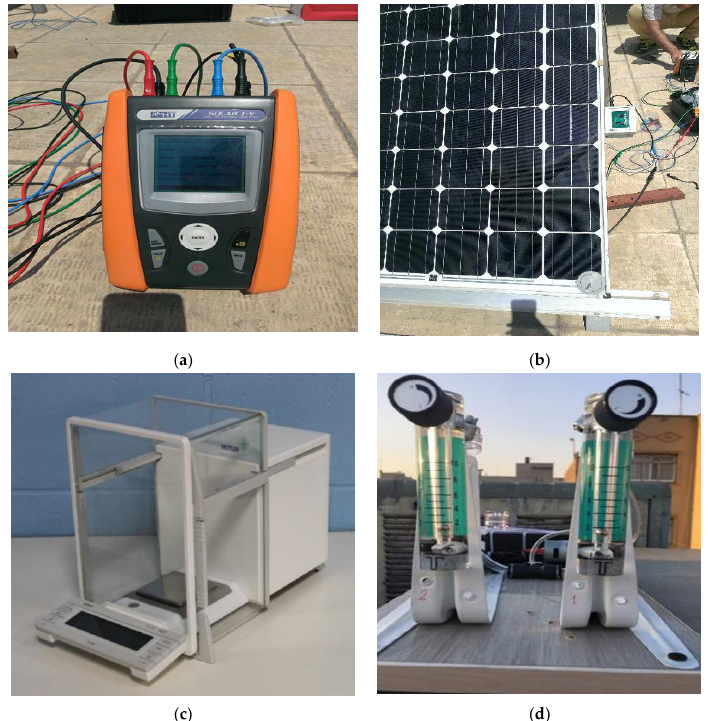
Figure 2. The measuring tools used in the experiments: ( a ) Solar PV System Tester, ( b ) HT304N, ( c ) Mettler AT201, ( d ) Ambient sampling pump machine. To clarify steps of the experiment in different phases Figure 3 is provided. It is worth mentioning that the diagrams of this paper which are related to the voltage-current and generated power, are obtained from the “PVCHECKw Solar System Tester” device and “Top view”. Moreover, the MATLAB software is used for drawing voltage-current changes for the dust deposited.